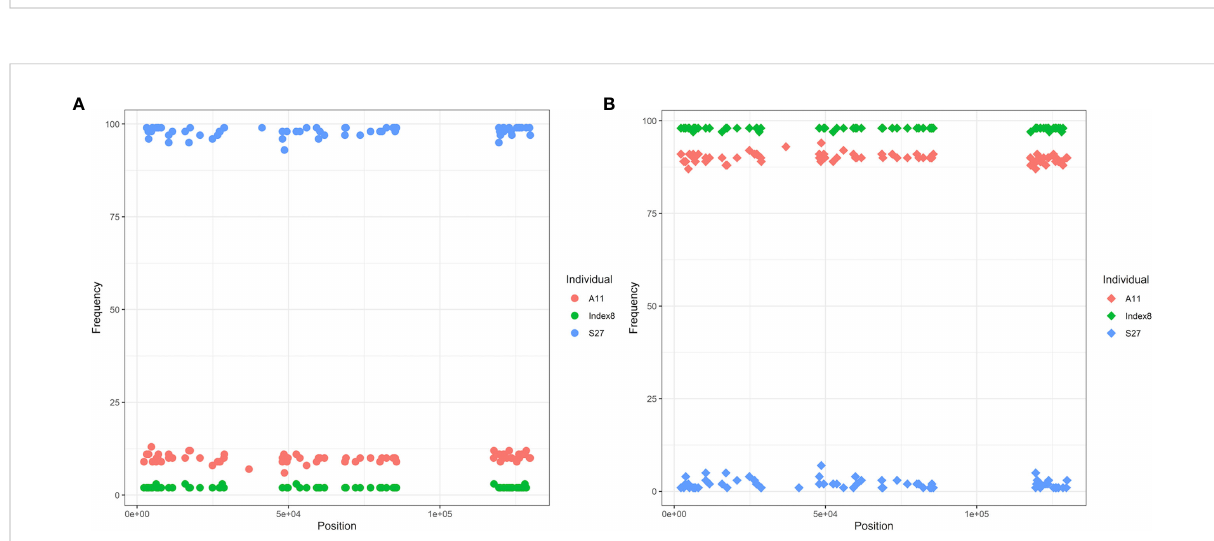
FIGURE 10 Diagram of allele frequencies of the 105 SNP loci different in Type 1 and Type 2 plants. (A) Frequency of the Type 2 alleles at these 105 loci. (B) Frequency of the Type 1 alleles at these loci. Only the frequencies of SNPs were recorded and compared here, as accurate indel frequencies were hard to